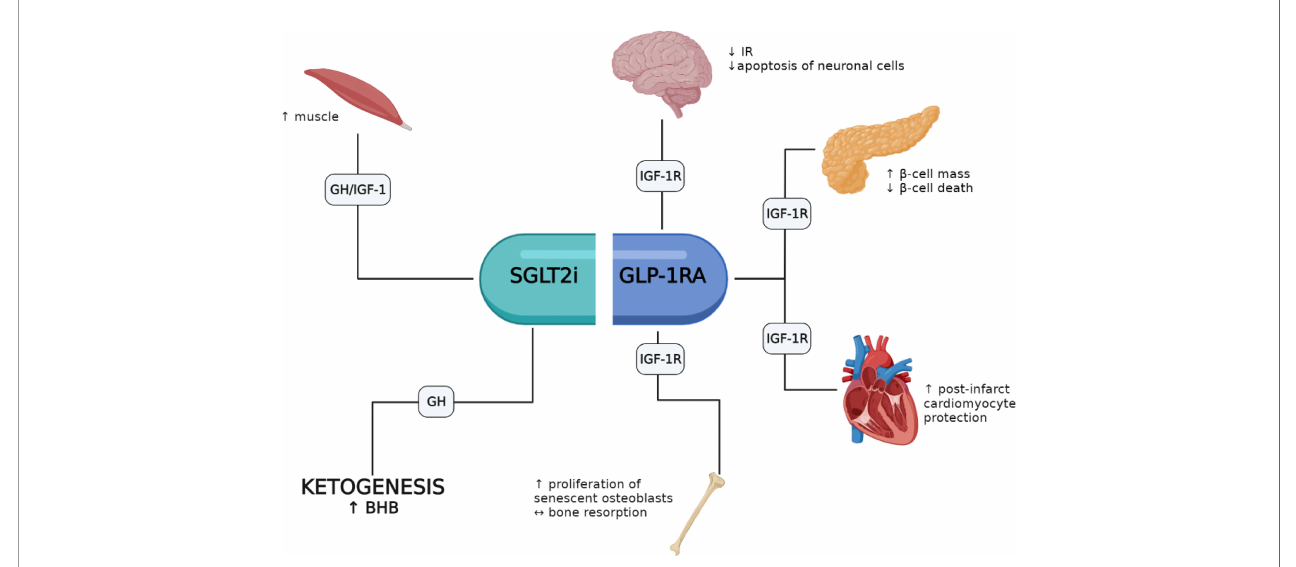
FIGURE 1 | Potential involvement of the GH/IGF-1/IGF-1R axis in the pleiotropic effects elicited by GLP-1RAs and